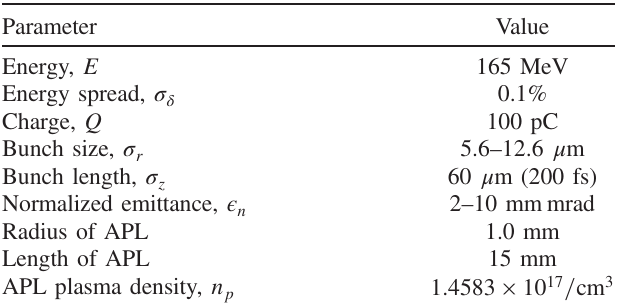
TABLE I. Electron beam parameters for the AWAKE RUN 2 experiment before injection into the plasma wakefield together with APL specifications. An emittance of 2 mm mrad was used as the baseline parameter.